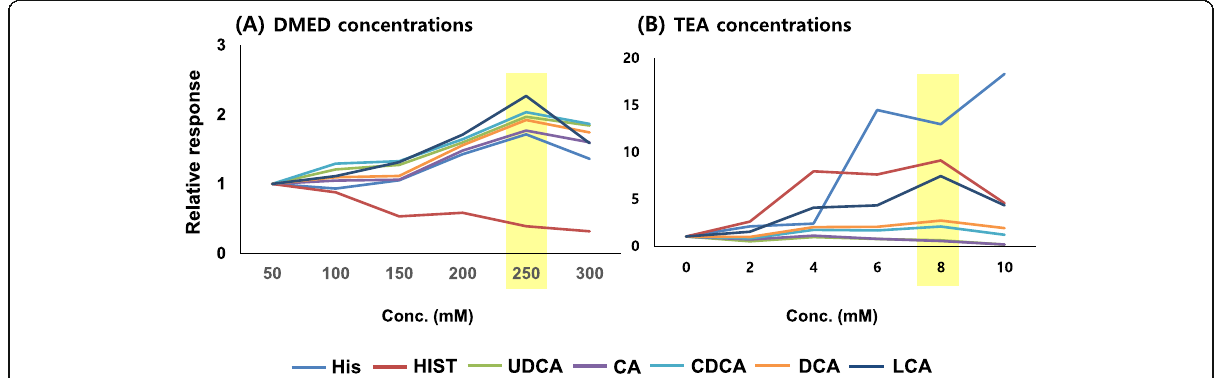
Fig. 2 Influence of derivatization conditions including a DMED concentrations and b TEA